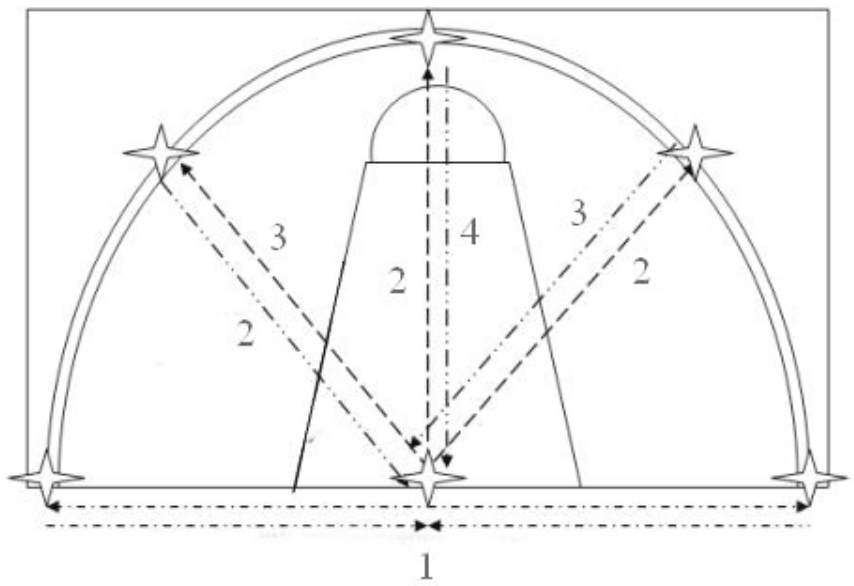
Fig.1. Diagram of test “Speed of defensive movements”: 1 – Moving by side steps; 2 – Run with face forward; 3 – Defensive movements with back forward; 4 – Usual movements with back